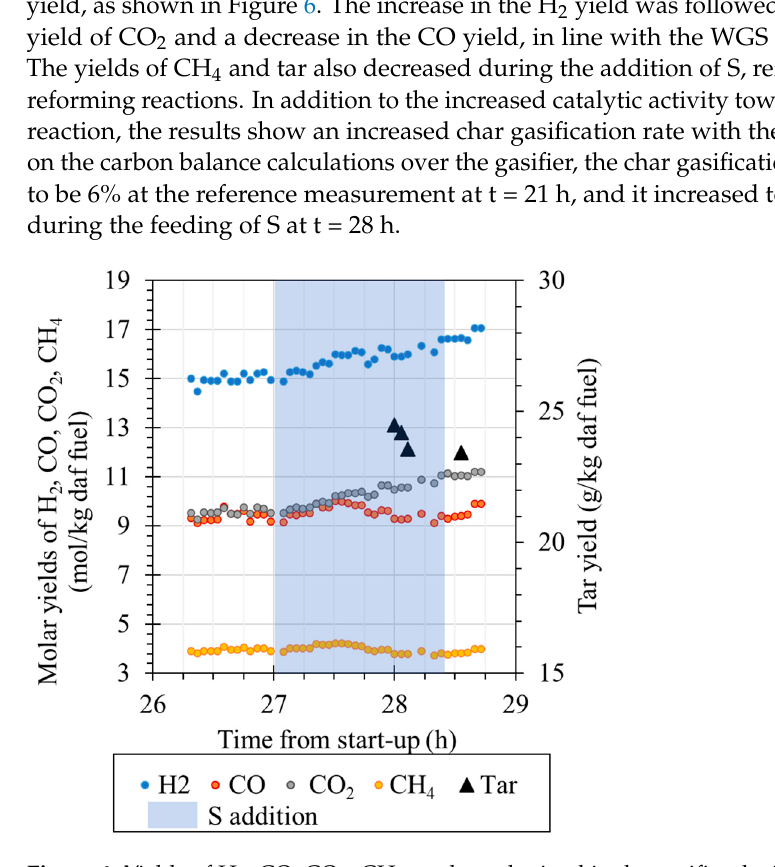
Figure 6. Yields of H 2 , CO, CO 2 , CH 4 , and tar obtained in the gasifier during the first continuous addition of S to the boiler bed.